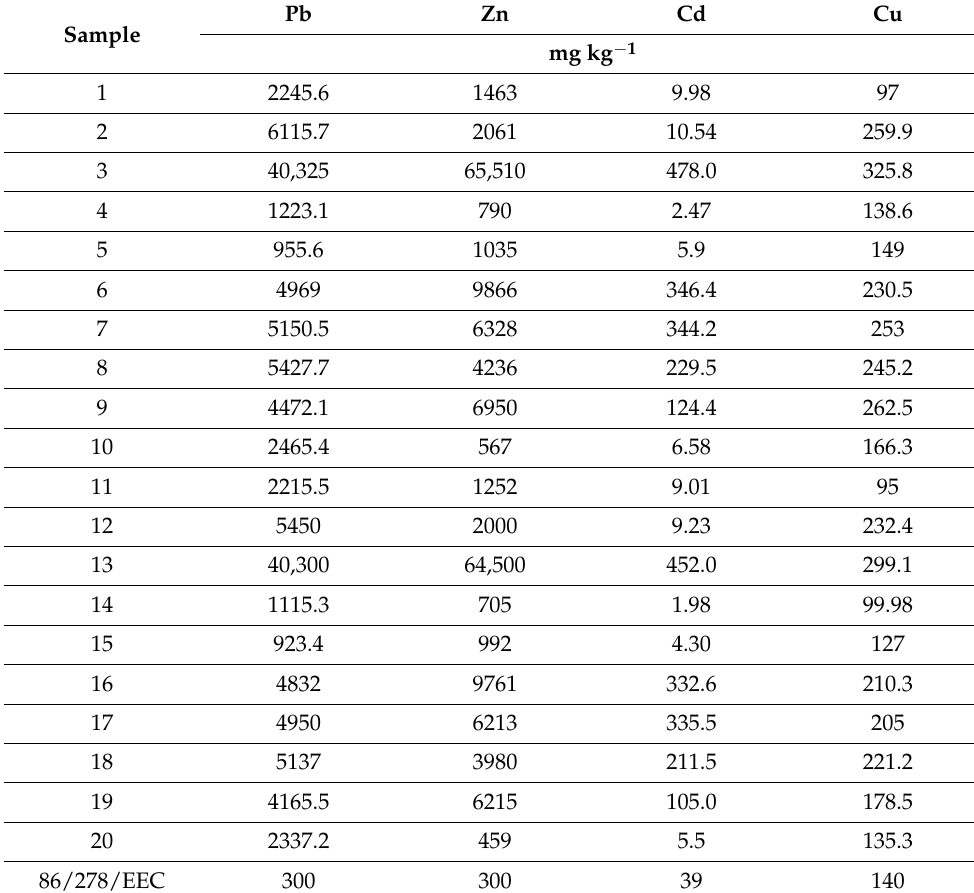
Table 1. The amount of the heavy metals (mg kg − 1 ) measured in the top soil of the Sitnica area.